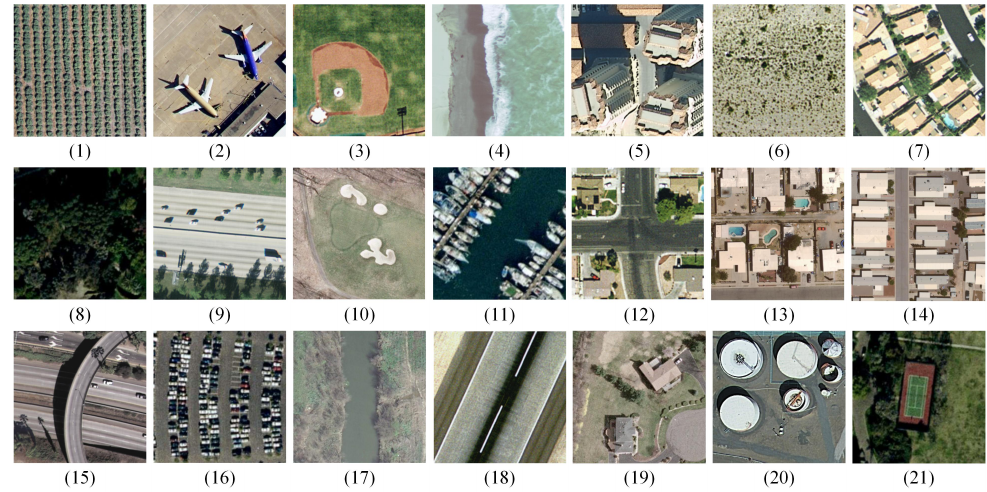
Figure 5. Examples of the UCML